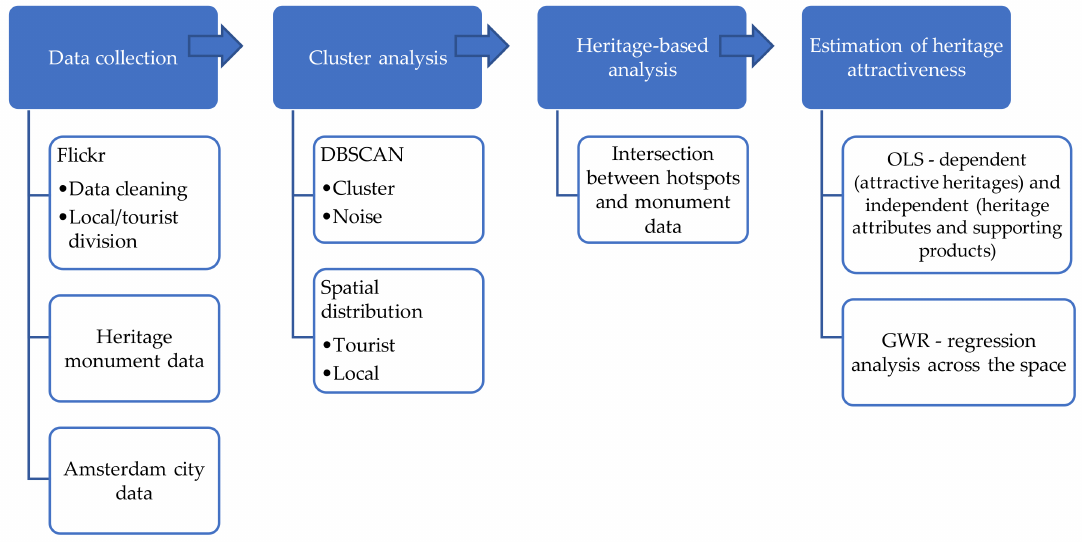
Figure 1. Methodological flow chart used in the data